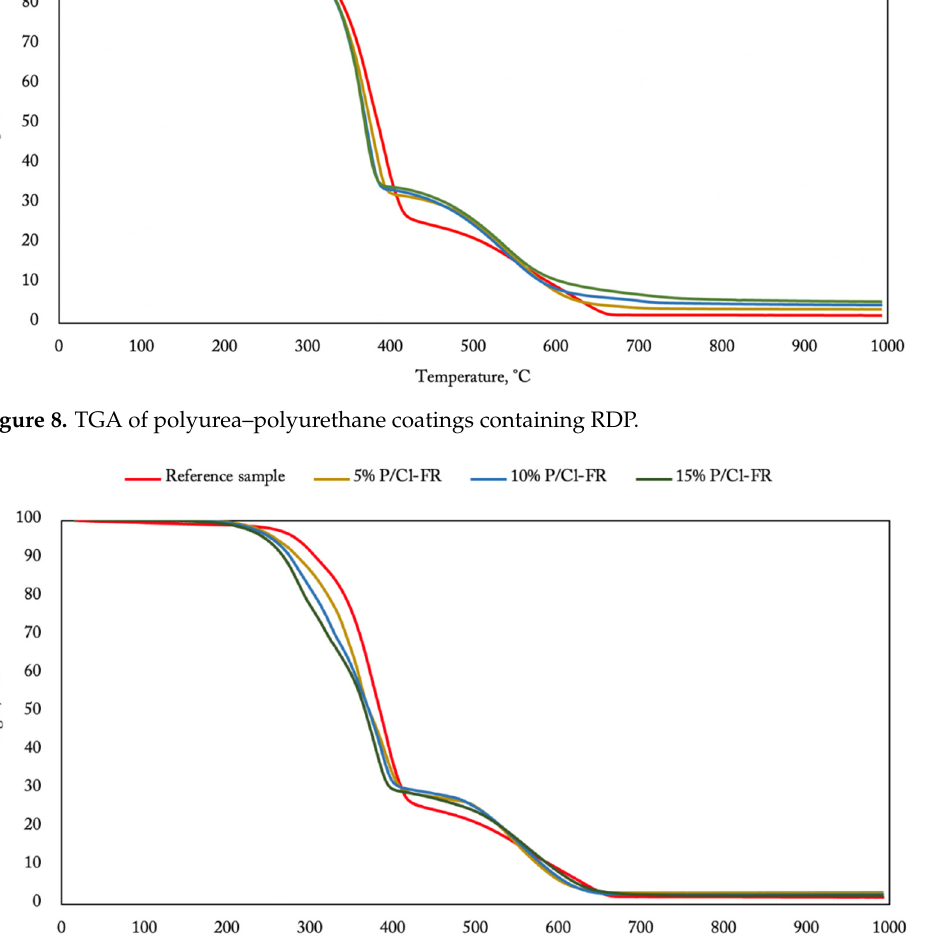
Figure 9. TGA of polyurea–polyurethane coatings containing TCPP.